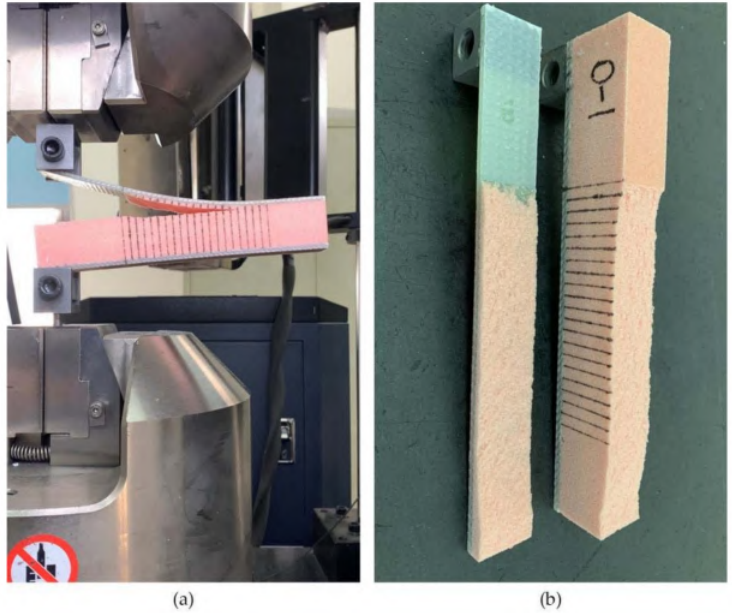
Figure 13. ( a ) Setup for FH-0-1 and ( b ) FH-0-1 specimen after